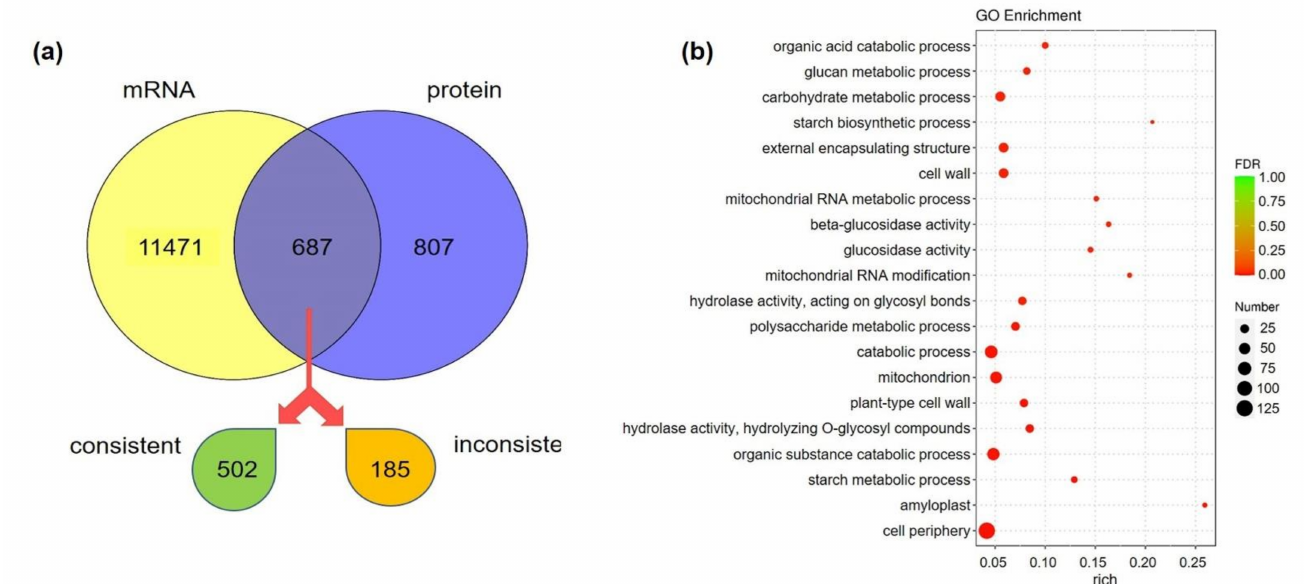
Figure 5. Conjoint analyses of transcriptome and proteome. ( a ) Correlation analysis of numbers of DEGs and DEPs. ( b ) GO functional-enrichment analysis of the differentially expressed correlations (DECs): X axis indicates rich factor; Y axis means GO terms. Rich factor is the ratio of DEC number, annotated in this term to all gene numbers. Greater rich factor represents greater intensiveness. The number of DECs is represented by the size of the circle, with a larger circle indicative of more DECs. FDR is false discovery rate ranging from 0–1, with a lower FDR indicative of greater intensiveness. Only the top 20 enriched terms are